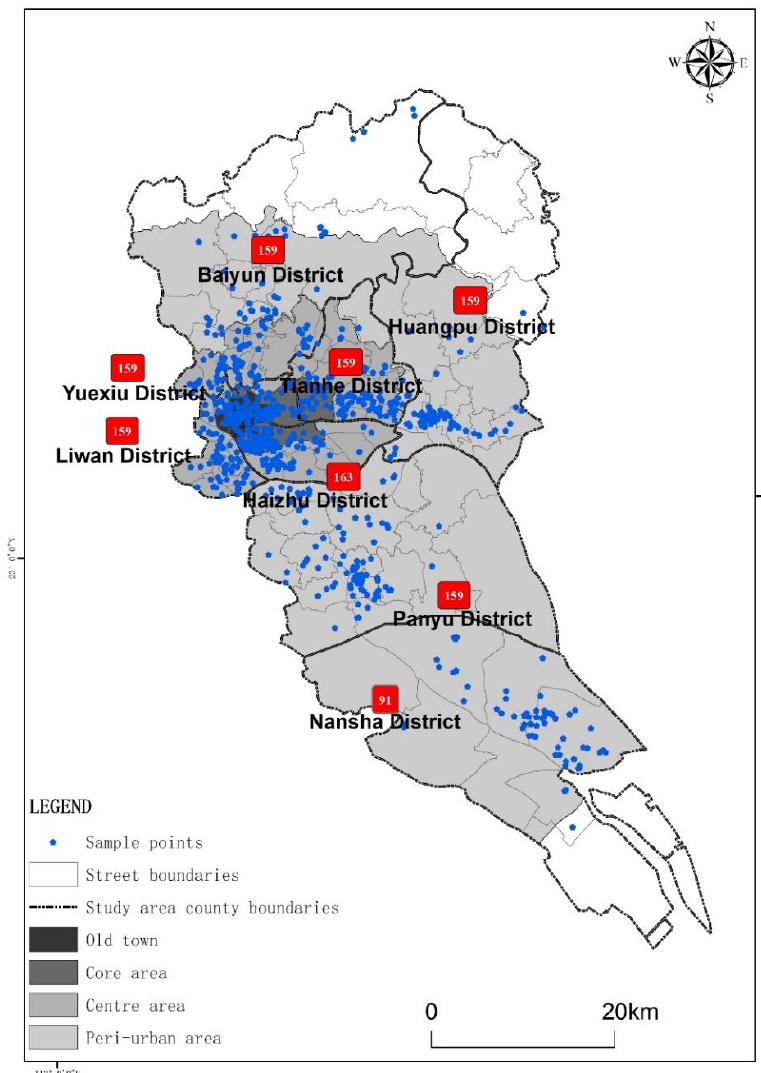
Figure 4. Spatial distribution of